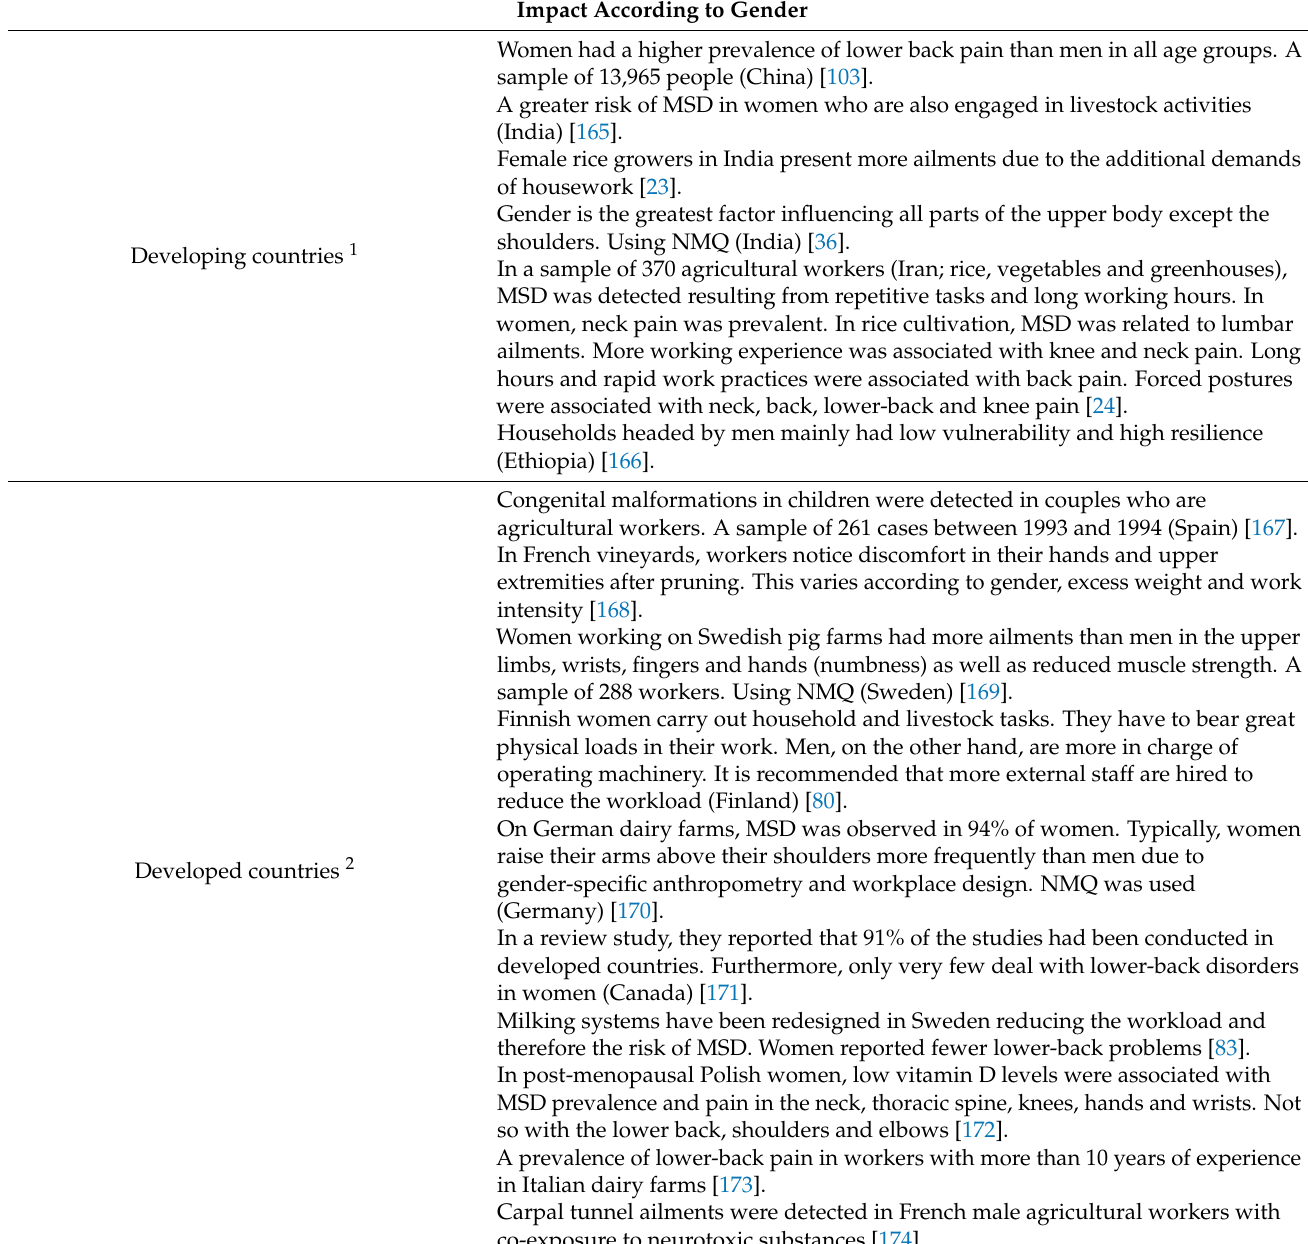
Table A8. MSD research in agriculture (1995–2020). Category: Impact according to gender. Impact According to Gender